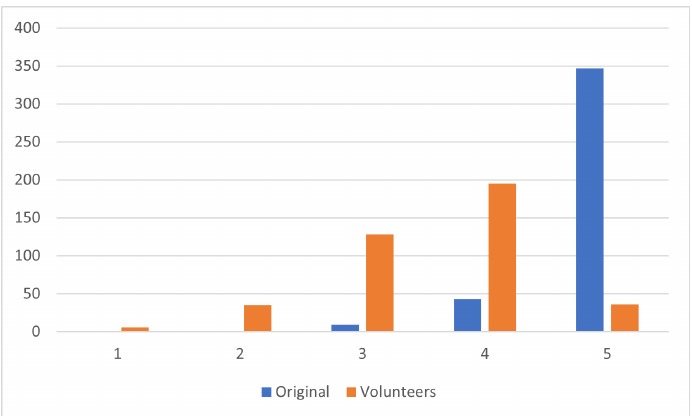
Figure 4. Distribution of the ESO and the ESV side by side.